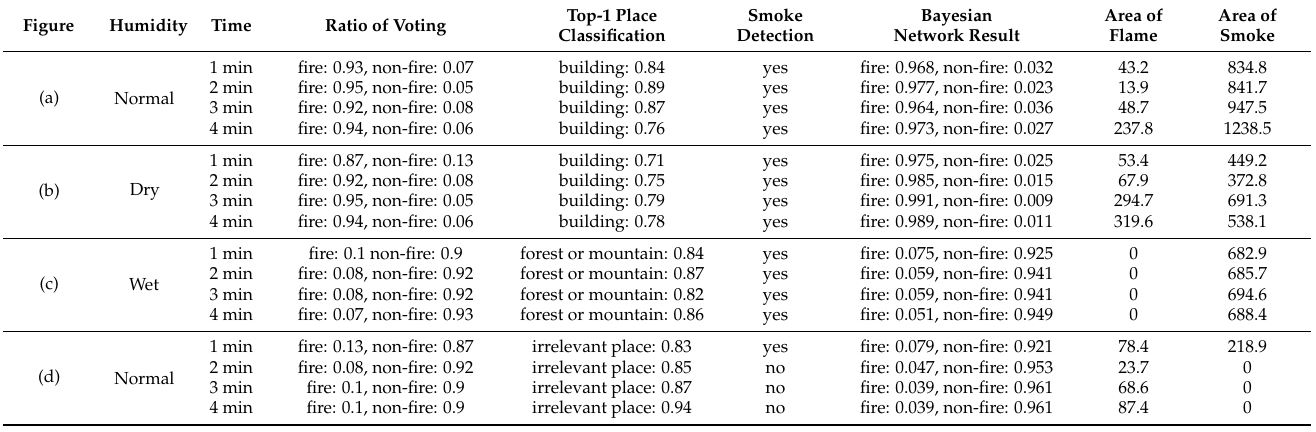
Table 14. Experimental results for Figure 11 [26].